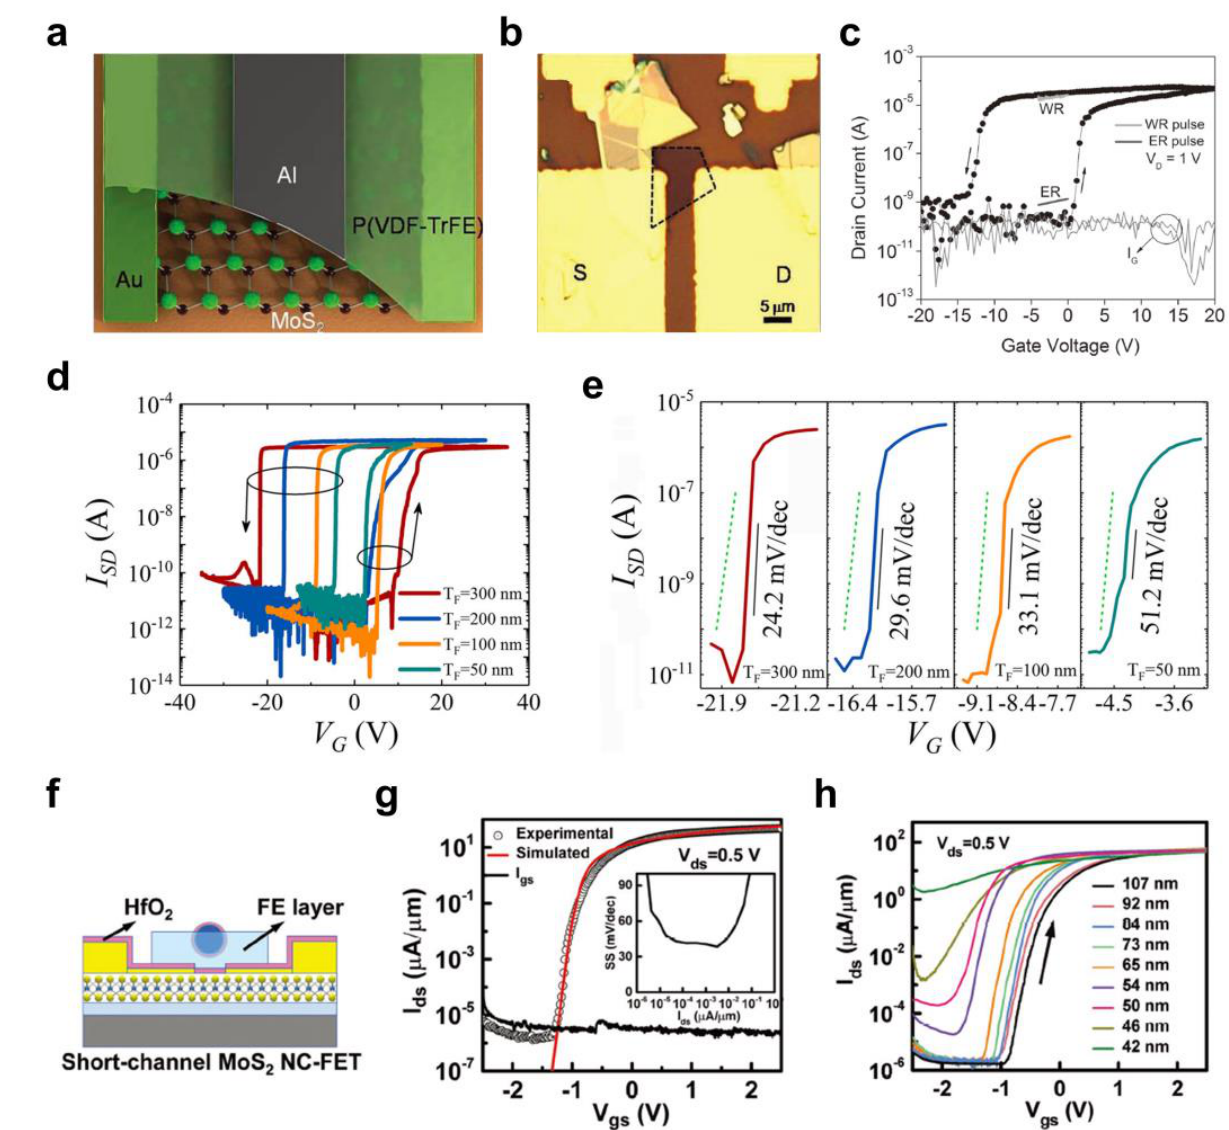
Figure 7. ( a ) Schematic illustration and ( b ) optical microscope image of the 2D MoS 2 memory device using ferroelectric P(VDF − TrFE). ( c ) The transfer characteristics of the ferroelectric memory with single − layer MoS 2 [127]. Copyright © 2012, John Wiley and Sons. The transfer curves of 2D MoS 2 NC − FETs based on P(VDF − TrFE) in the ( d ) overall operating voltage range and ( e ) sub- threshold region [133]. Copyright © 2017, Springer Nature. ( f ) Schematic illustration of the short − channel 2D MoS 2 NC − FETs employing HfO 2 /P(VDF − TrFE). ( g ) The experimentally measured transfer curve compared to that obtained in the numerical simulation (inset: the extracted SS at each I D level). ( h ) The change in transfer curves in relation to the channel length [134]. Copyright © 2018, John Wiley and Sons. Table 2. Summary of materials and electrical characteristics of the 2D semiconductor FETs based on ferroelectric polymer gate dielectric materials.